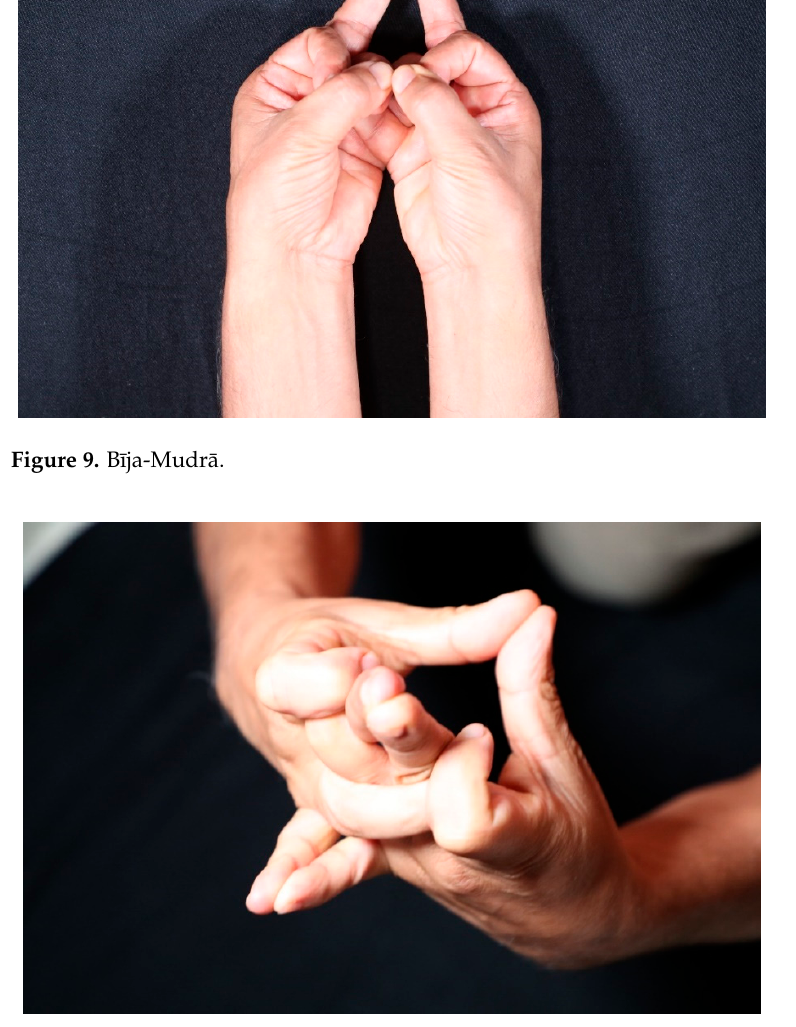
Figure 10. Trikha ṇḍ ā -Mudr ā . Figure 10. Trikhan.d.